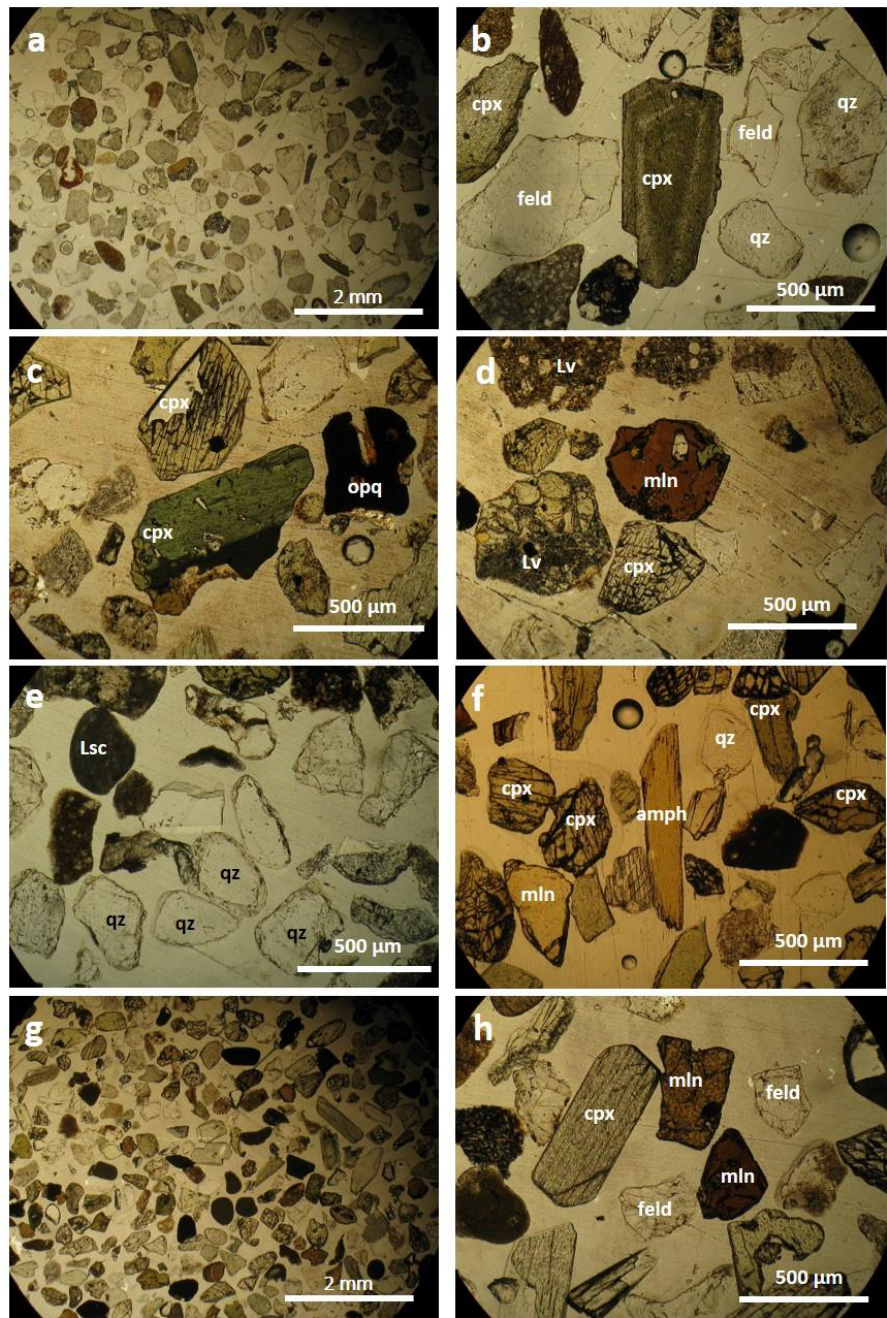
Figure 4. Microphotos of diagnostic grains in the studied samples. All the images are in plane- polarized light. ( a ): sample OFA-3b, general view of the sand. Garnet (dark brown), light and dark-green pyroxene, quartz, feldspar and volcaniclastic rock fragments are visible. ( b ): sample OFA-3b, zoned, dark-green clinopyroxene (cpx), surrounded by quartz (qz) and feldspar (feld) crystals. A light- green pyroxene is also visible on the left; ( c ): sample OFA-13bis. Dark-green pyroxene surrounded by dark volcanic glass and light green pyroxene. An opaque (opq) is also visible on the right; ( d ): sample OFA-13bis, sub-rounded melanite (mln) crystal; ( e ): sample OFA-22, rounded quartz crystals and carbonatic sedimentary rock fragments (Lsc); ( f ): sample OFA-22, amphibole (amph), melanite and pyroxene crystals; ( g ): sample CA, general view of the sand. Light and dark green pyroxene, melanite, quartz and feldspar crystals and well-rounded carbonatic rock fragments are visible; ( h ): sample CA, melanite, pyroxene and feldspar